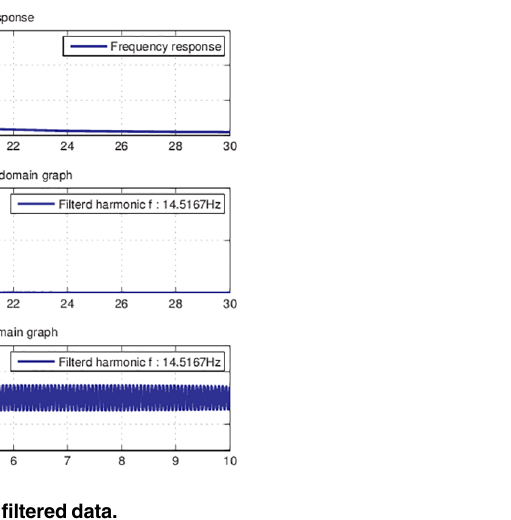
Fig 9. IIR filter frequency response and filtered